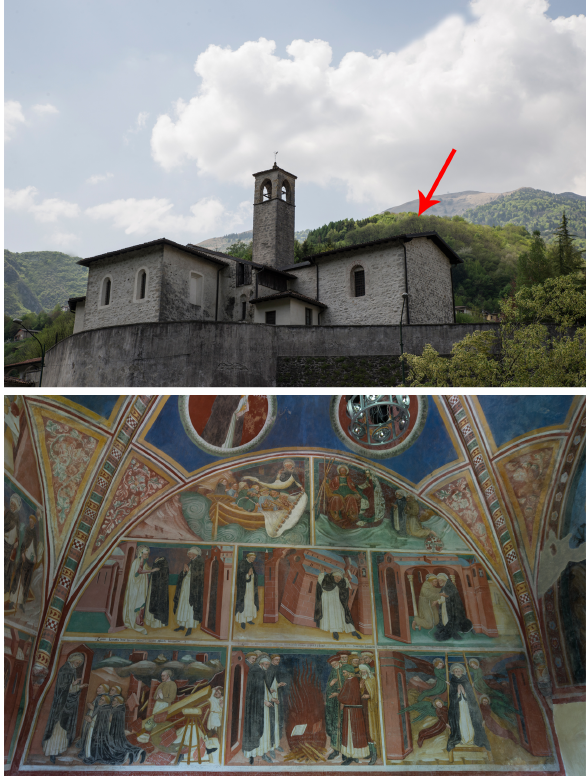
Figure 2. Chirch of S. Filastrio (above) and inside view of frescoed chapel (below)